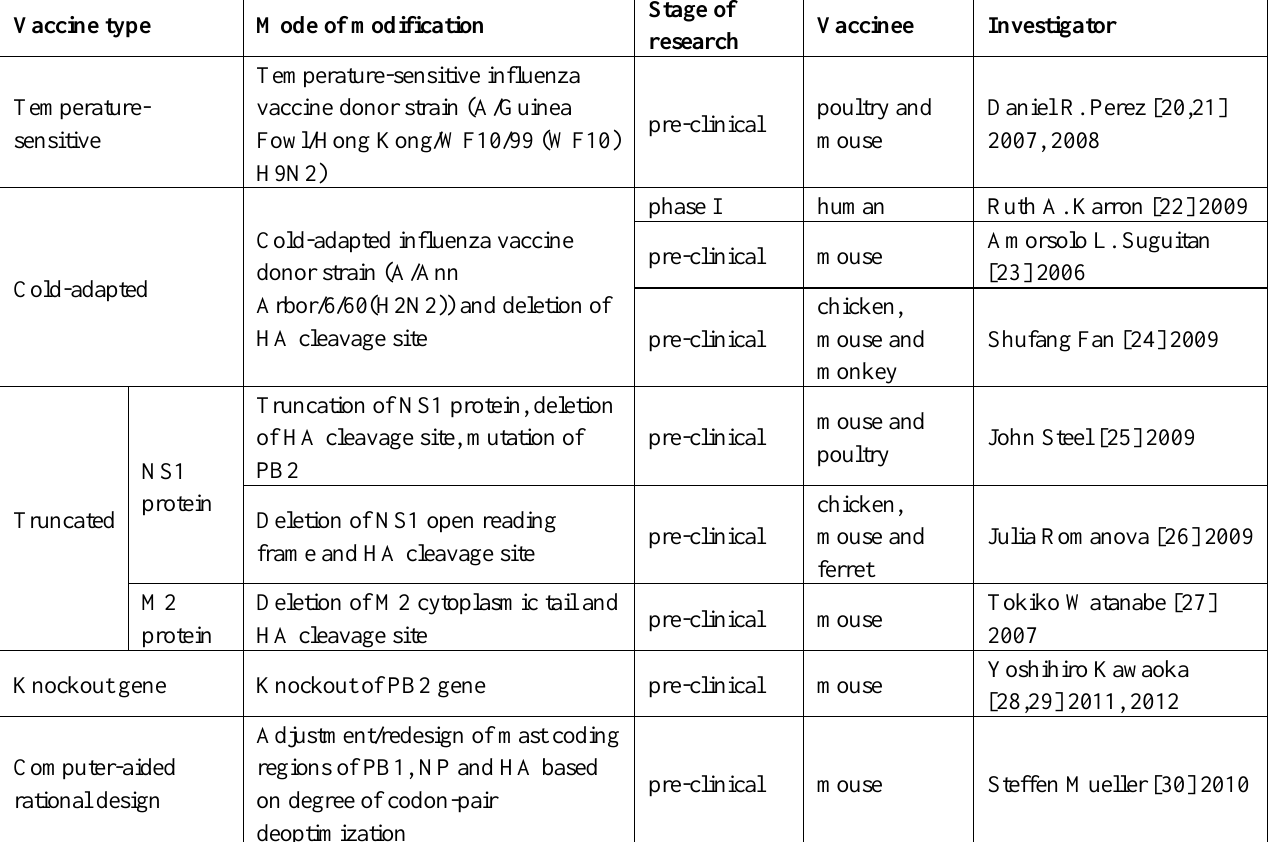
Table 1. Overview of studies on H5N1 live attenuated vaccines reported so